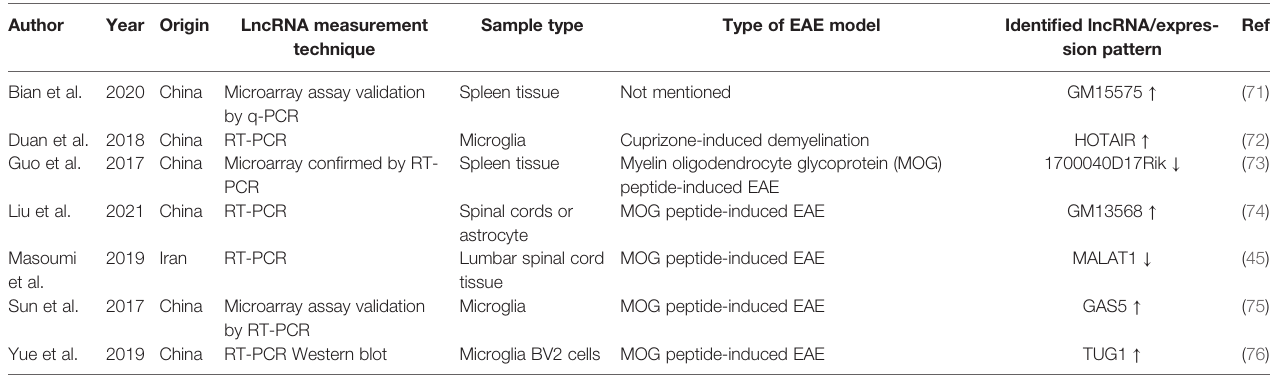
TABLE 2 | Details of the included animal